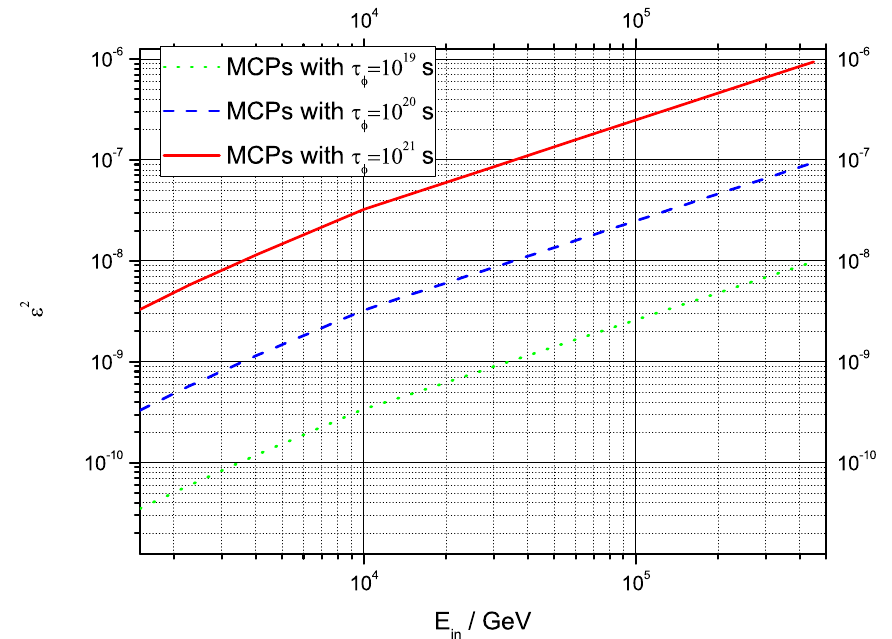
Figure 4 . With the different τ φ (= 10 19 s, 10 20 s and 10 21 s), the upper limit on (cid:15) 2 at 90% C.L. was computed, respectively, assuming no observation at IceCube in 6